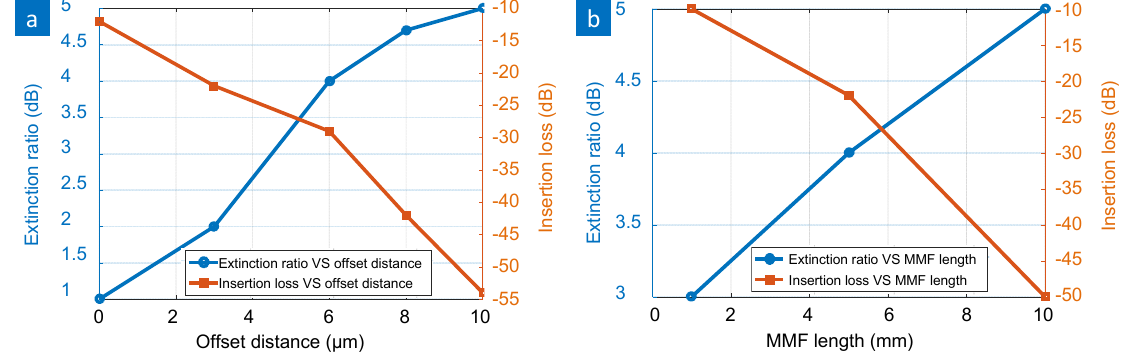
Fig. 8 | Summarized extinction ratio as well as insertion loss variation when the SMF shifts away from the TCF in transverse direction (a) and the extinction ratio and insertion loss variation with different MMF lengths in SCF interferometer